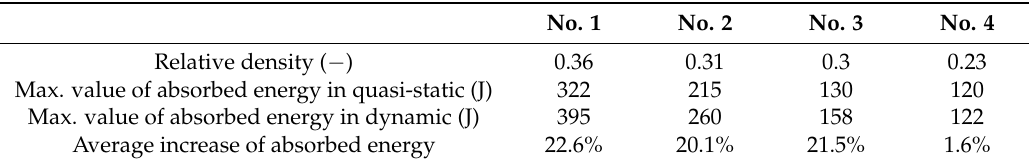
Figure 21. The comparison of deformation energy plots between dynamic and quasi-static results (1–4—the thin-walled honeycomb structures with the different cell size). Table 6. The comparison of the maximum values of absorbed energy referring to honeycomb structure specimens.